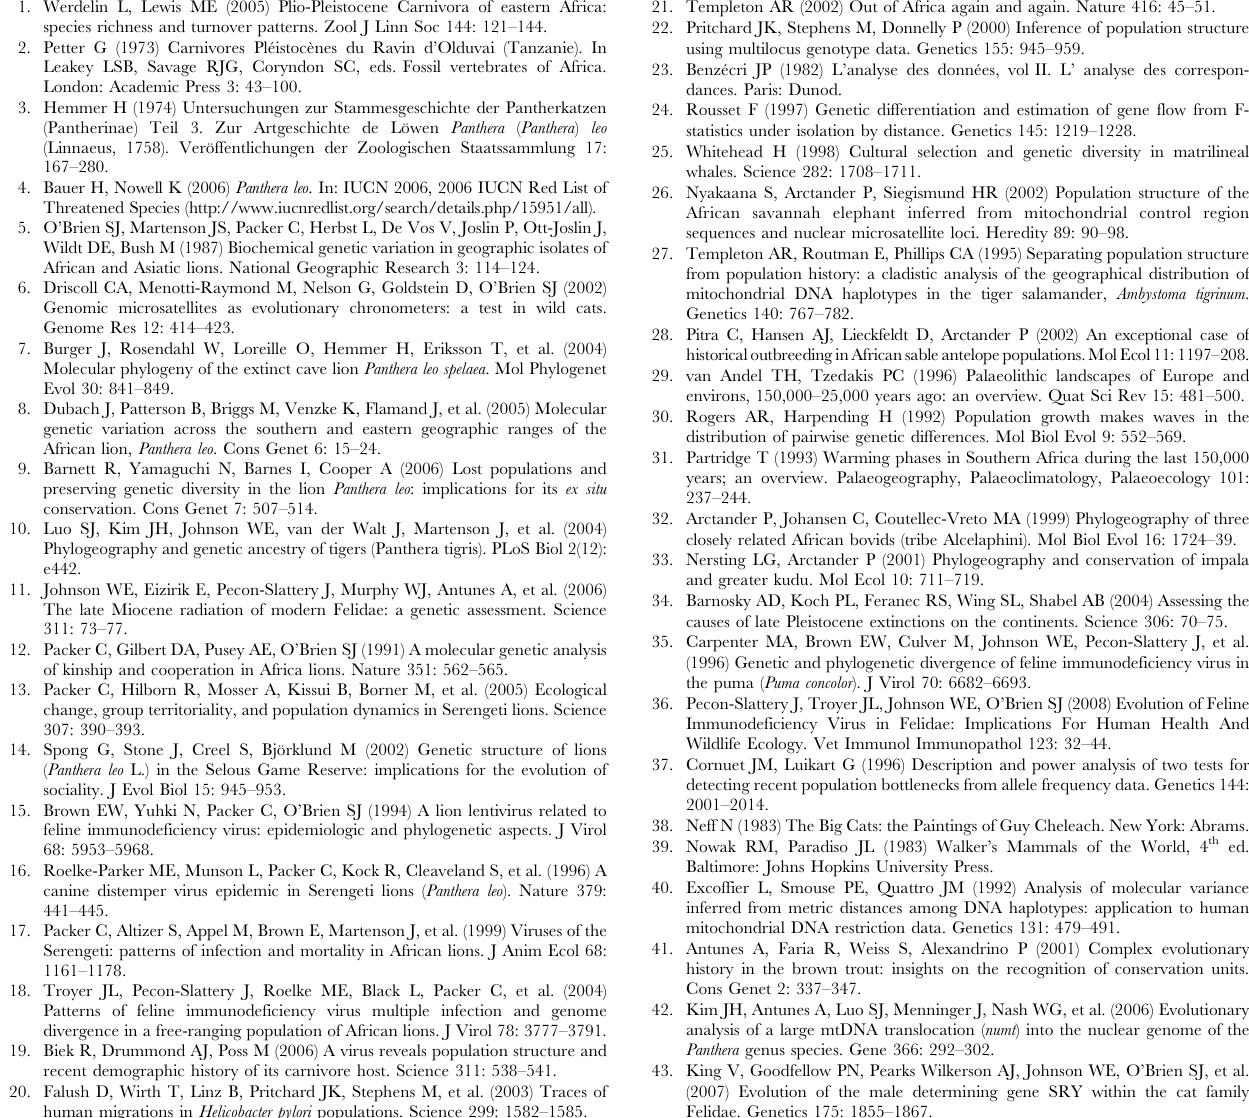
Table S9 Summary statistics for FIV Ple